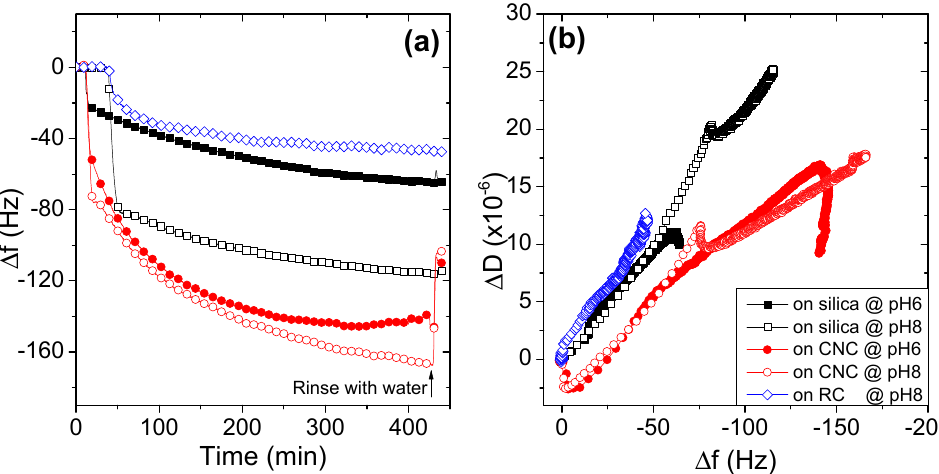
Figure 6. Effects of substrates and medium pH on the adsorption amount ( a ) and the conformation ( b ) of AmPAM adlayers. The tested AmPAM sample was of MW of 713 k and the polymer concentration was 100 mg/L. Ionic strength of solution was controlled at 0.02 M.